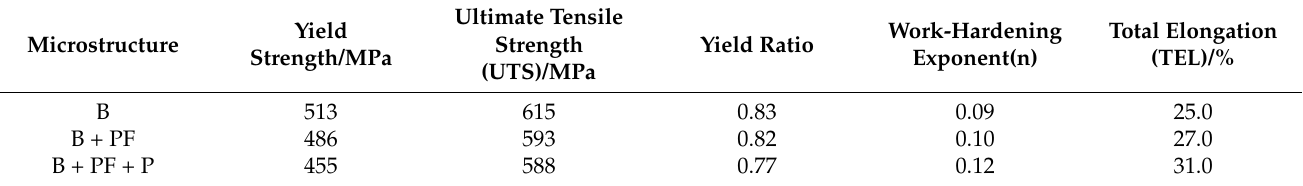
Table 2. Mechanical properties of three microstructures.